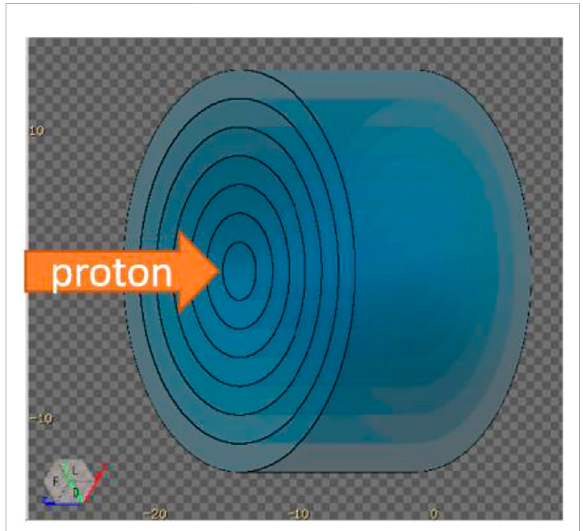
FIGURE 4 A water phantom with 7 layers ranging from a radii of 2 cm to 14 cm.TheUSRYIELDcardwasadopted toscore theneutronyield between each layer.